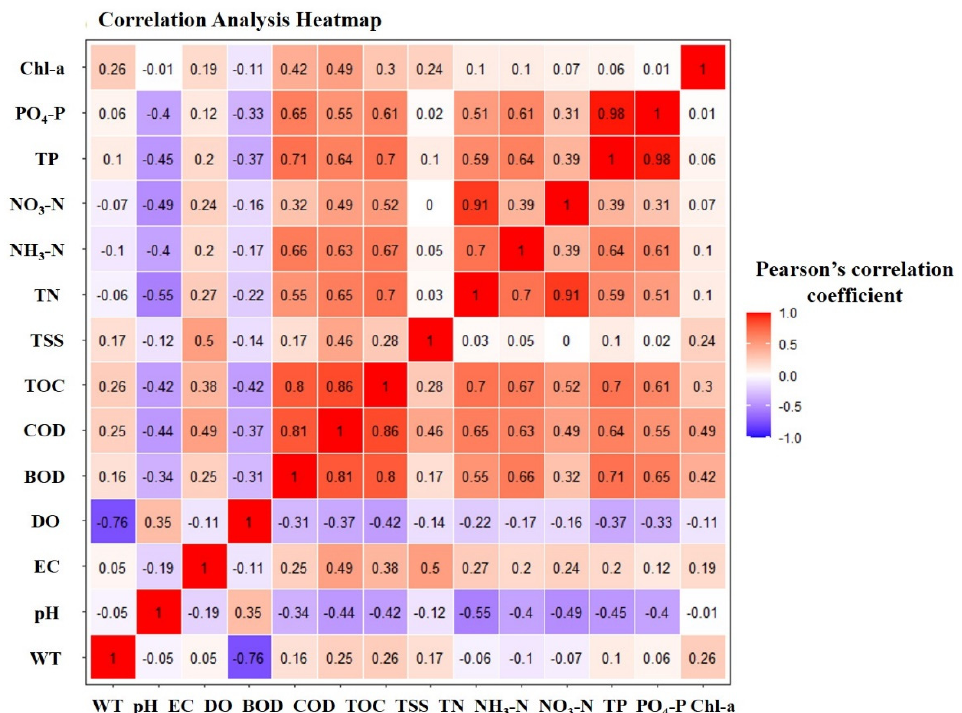
Figure 4. Pearson correlation coefficient matrix between water quality parameters in the Han River Basin, South Korea.